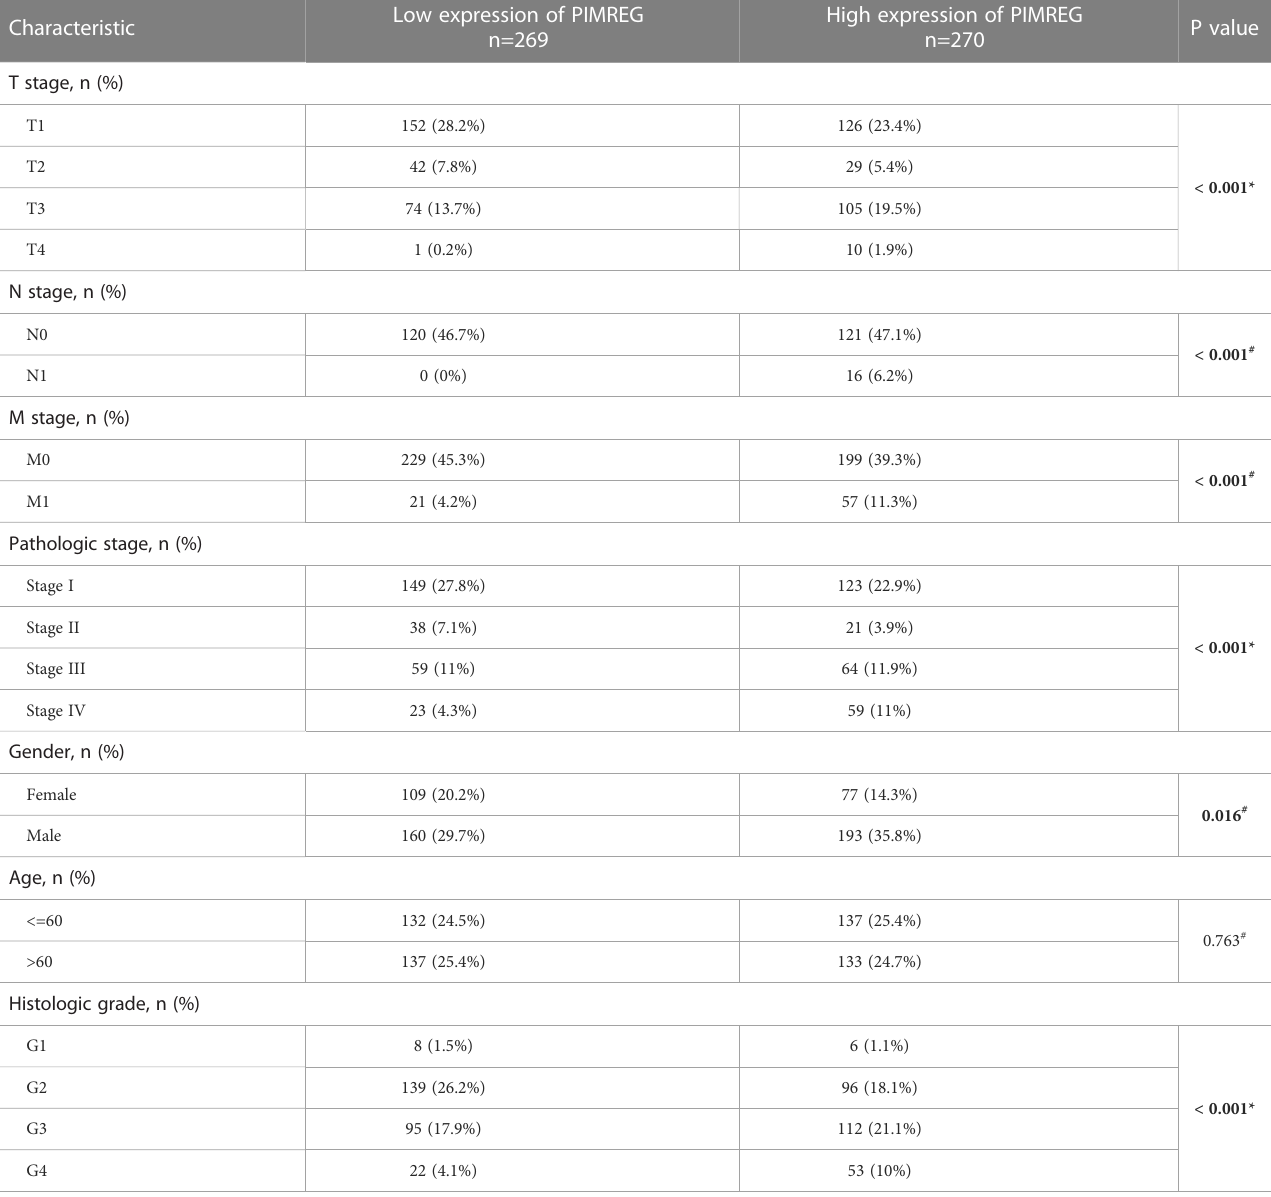
TABLE 2 The detailed baseline clinical pathological characteristics of the patients.